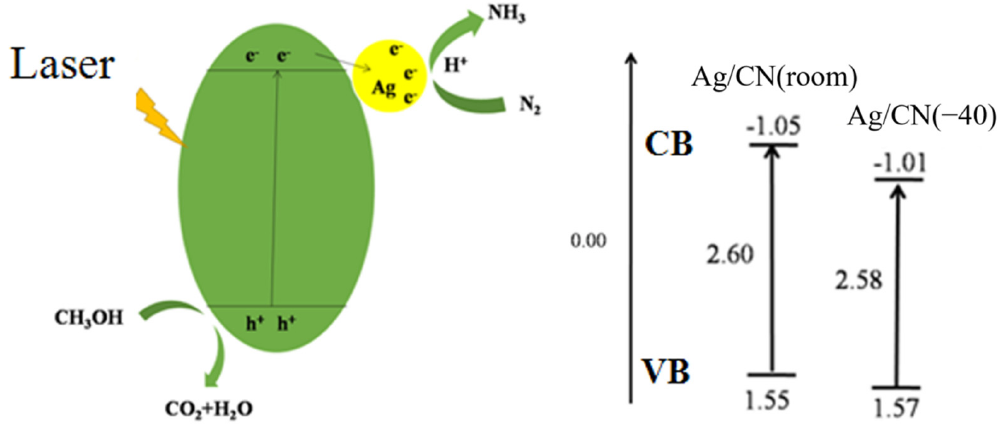
Figure 3. Schematic diagram of the band structure over Ag/CN for N 2 photofixation.